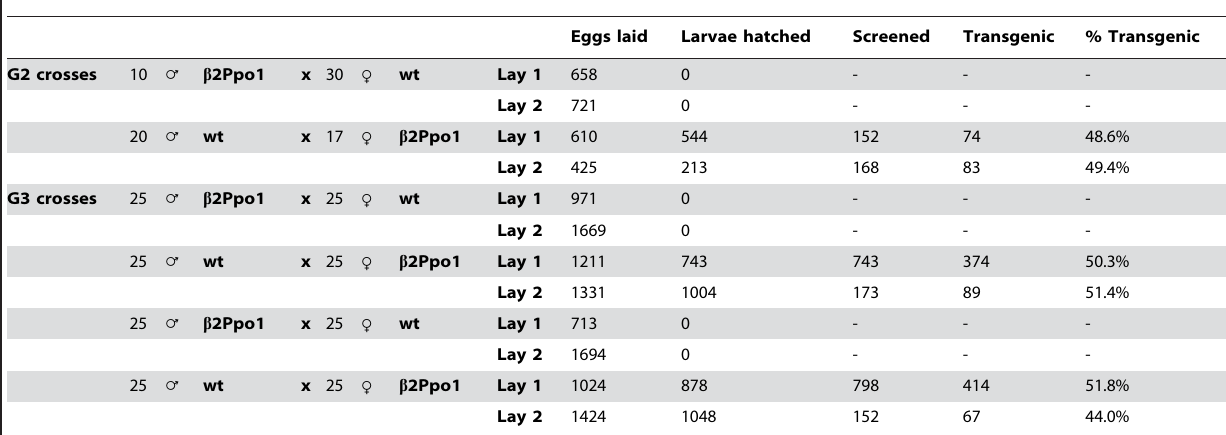
Table 1. Outcome of crosses between transgenic b 2Ppo and WT mosquitoes.